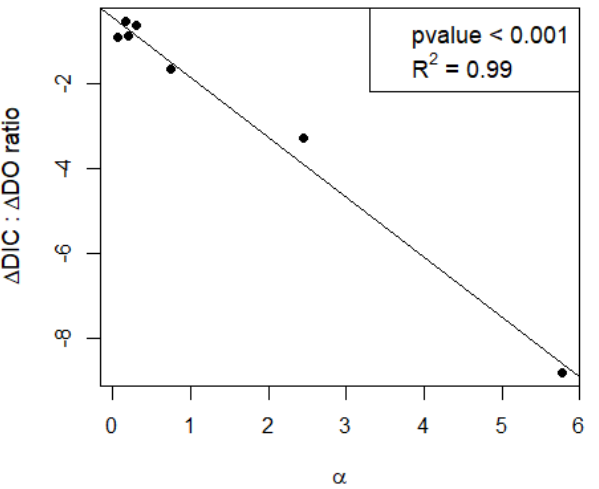
Figure 4. Relationship between the calcification/NEP ratio ( α ) and the response of dissolved inor- ganic carbon (DIC) to metabolism.